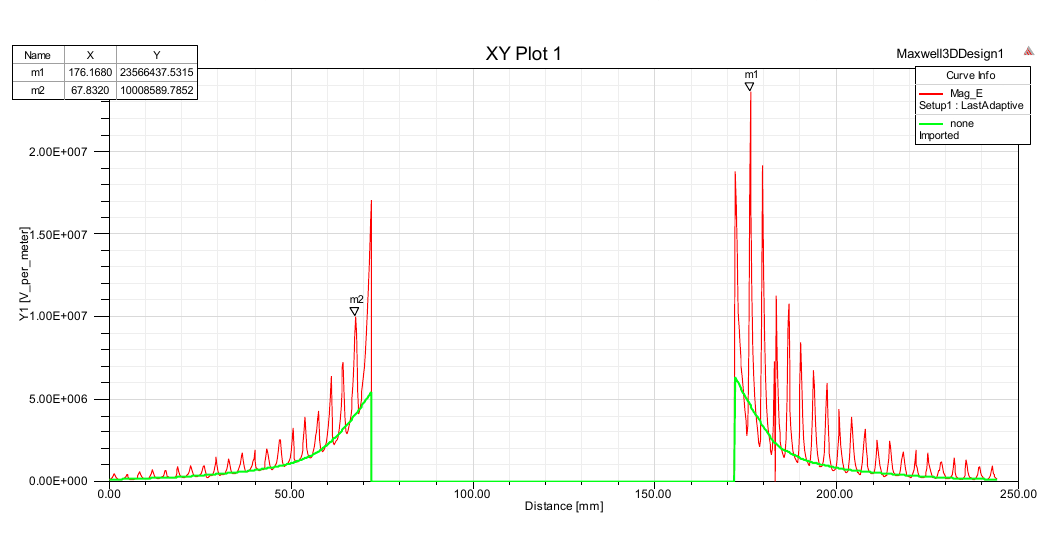
Figure 13. The distribution of electric field.